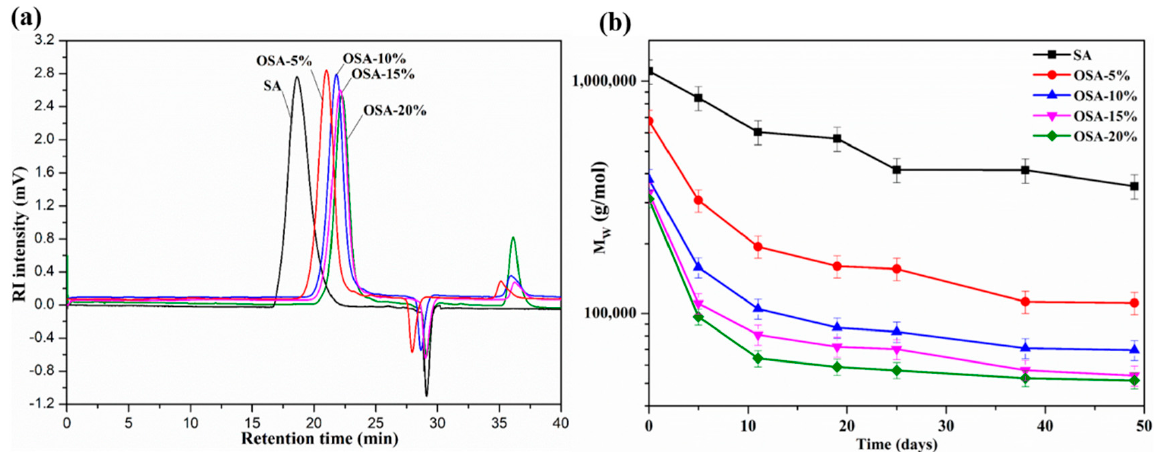
Figure 8. ( a ) GPC chromatographs of SA and OSA with various OD; ( b ) biodegradation curves of SA and OSA with various OD in PBS solution.